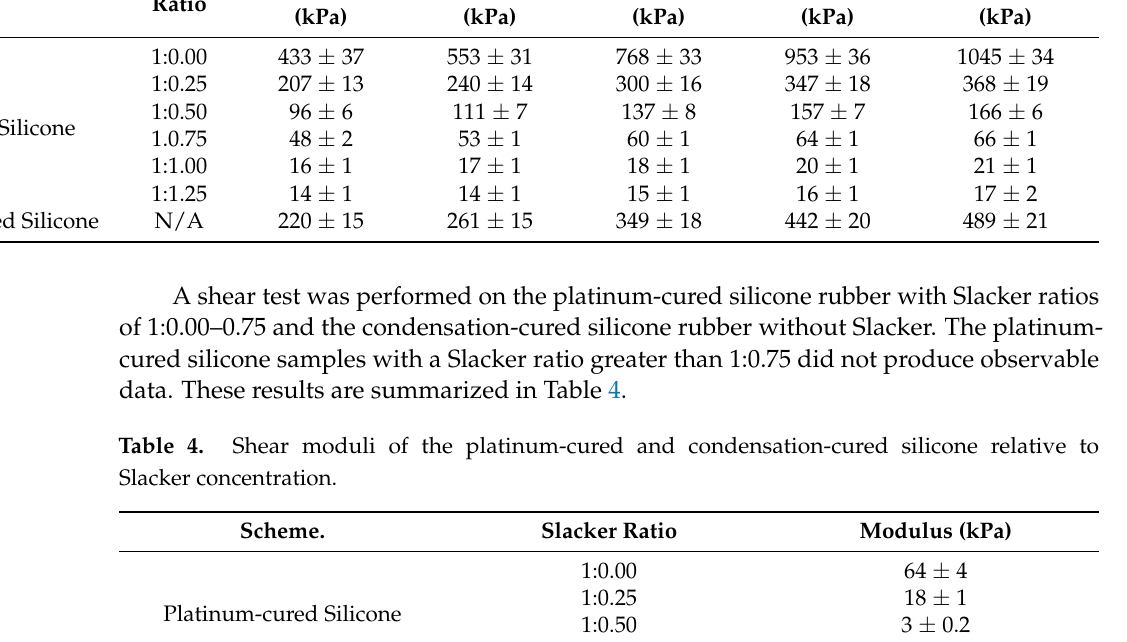
Compressive moduli of the platinum-cured and condensation-cured silicone relative to % strain and Slacker concentrations. Slacker Sample